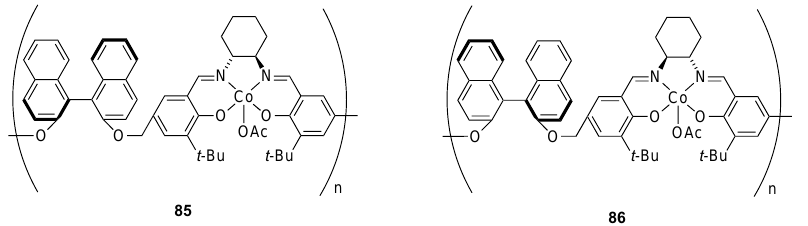
Figure 34. Polymeric Co–salen catalysts with 1,1’-bi-2-naphthol (BINOL) linkers.